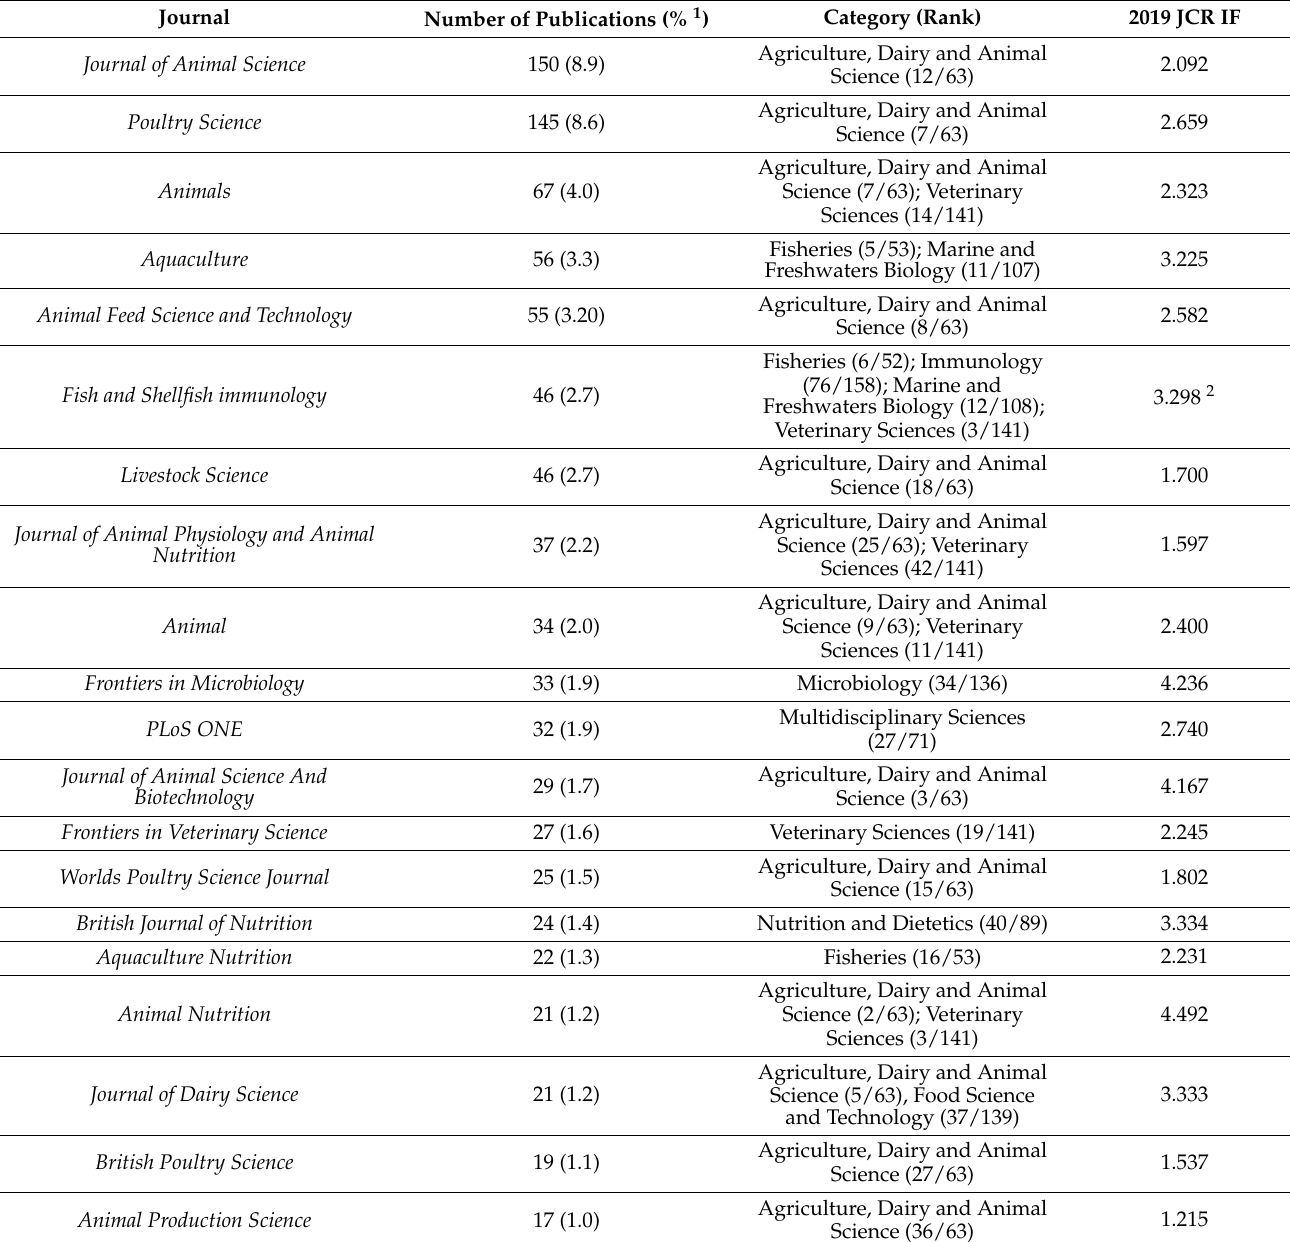
Table 1. Top 20 most prolific journals on veterinary gut health research sorted by number of